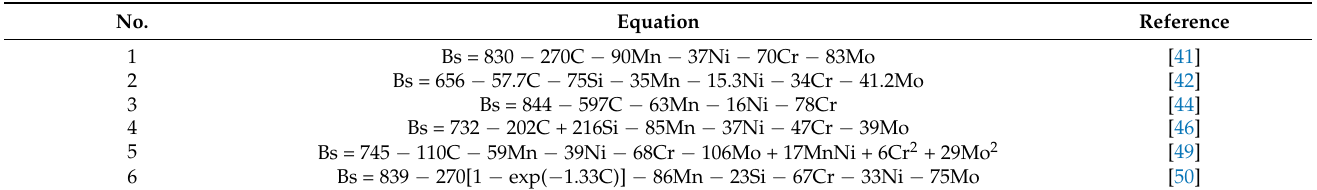
Table 4. Existing empirical formula to predict bainite start temperature ( ◦ C) of alloy steel using content (wt.%) of alloying